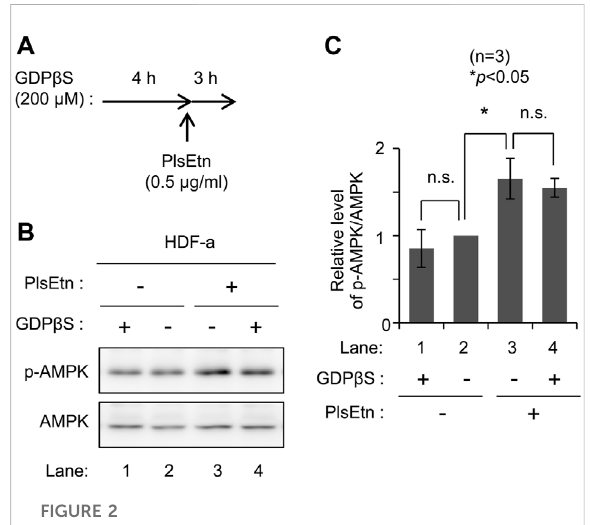
FIGURE 2 PlsEtn-mediated phosphorylation of AMPK is not inhibited by GDP β S (A) Schematic representation of the experimental procedure (B) Immunoblot for p-AMPK and AMPK in PlsEtn- treated HDF-a cells, cultured in the presence or absence of GDP β S (C) Amount of p-AMPK to total AMPK ( n = 3). Statistical signi fi cance was determined by Tukey – Kramer multiple comparisons test using the R